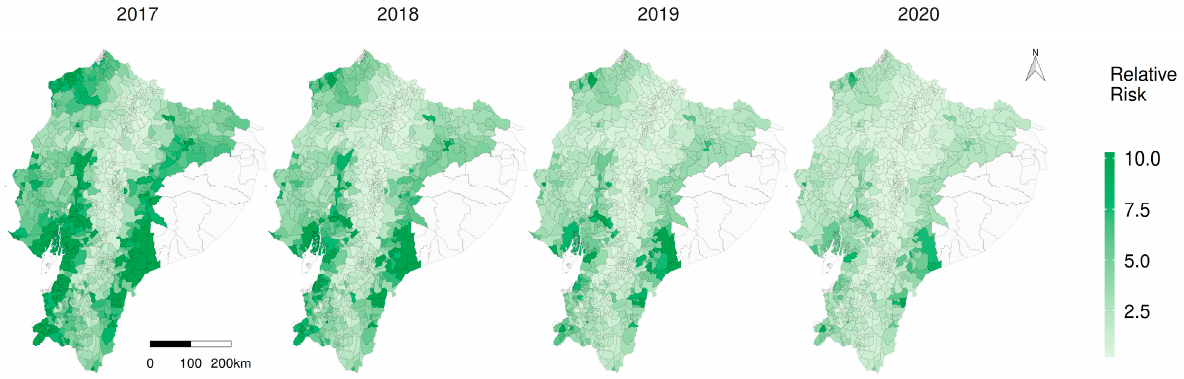
Figure 6. Spatiotemporal representation of the relative risk (RR) of CSF in Ecuador.